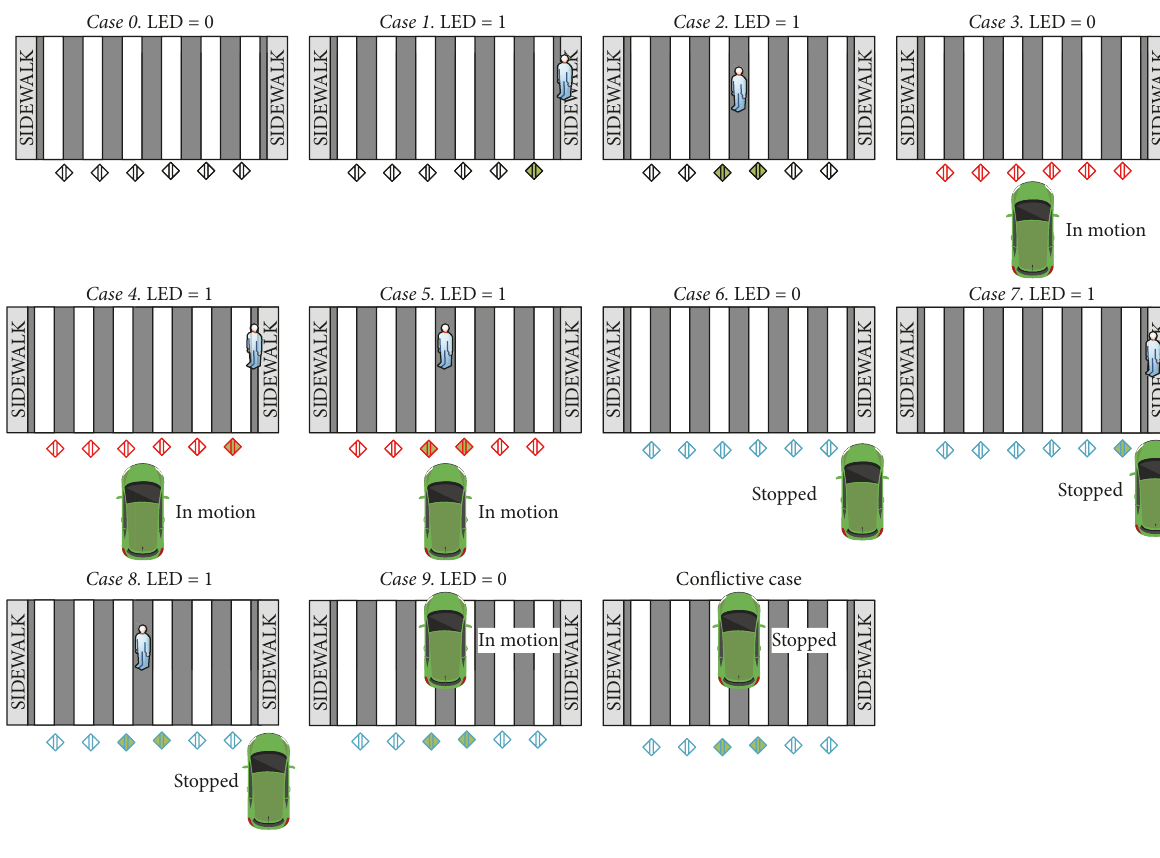
Figure 6: Case studies of the system